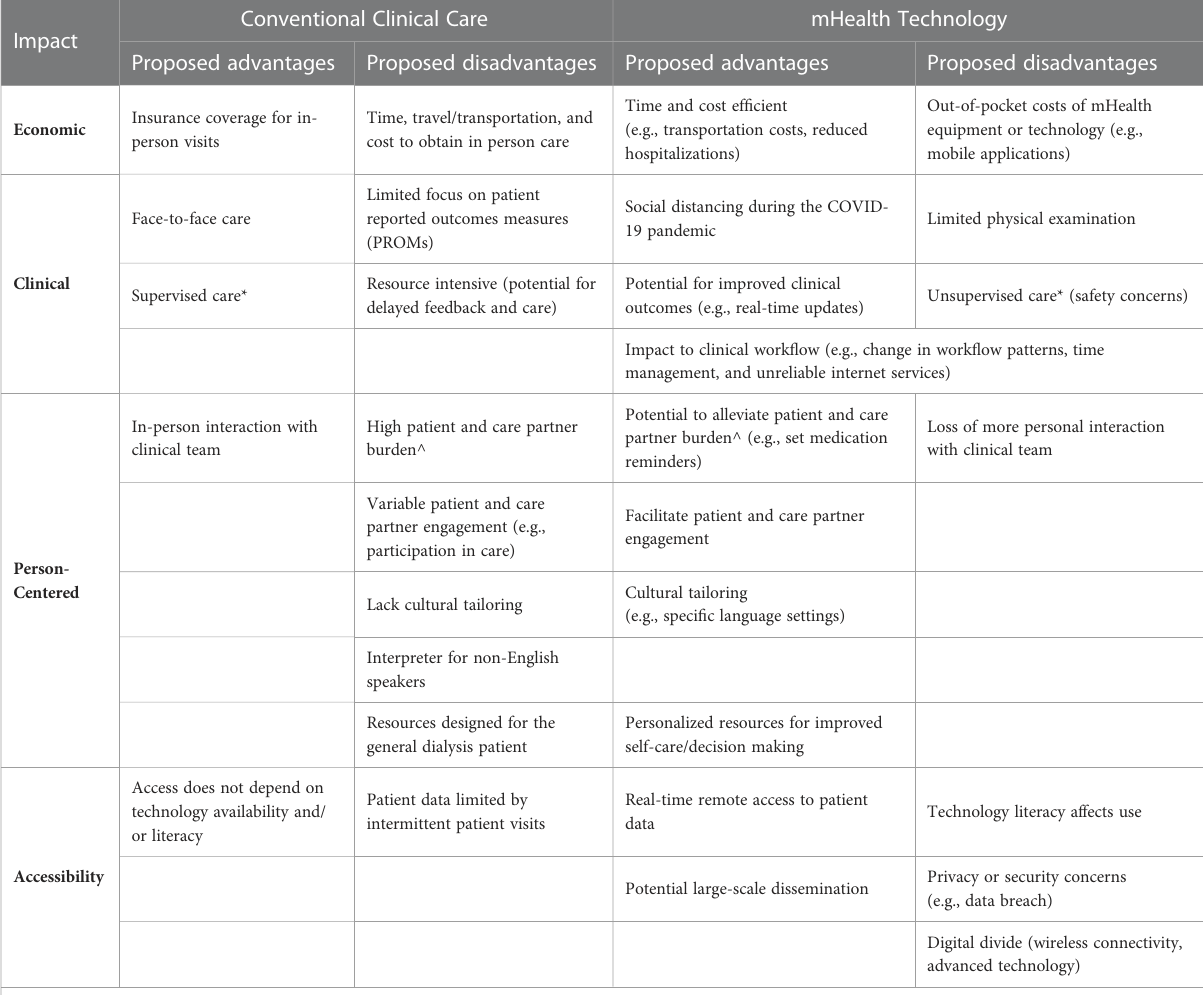
TABLE 1 Potential advantages and disadvantages with conventional clinical care vs mobile health (mHealth)